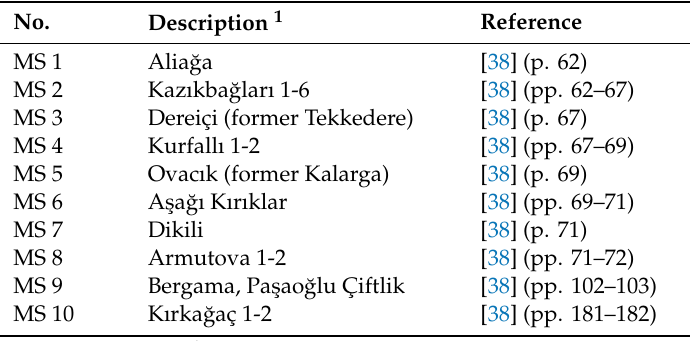
Table 3. Milestones found in the surroundings of